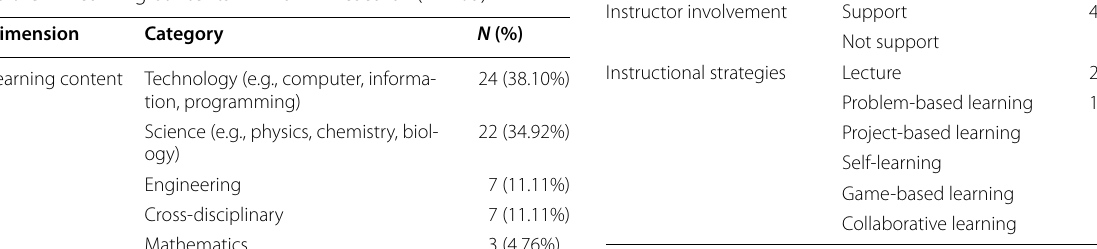
Table 4 Learning contents in AI-STEM research ( N Dimension